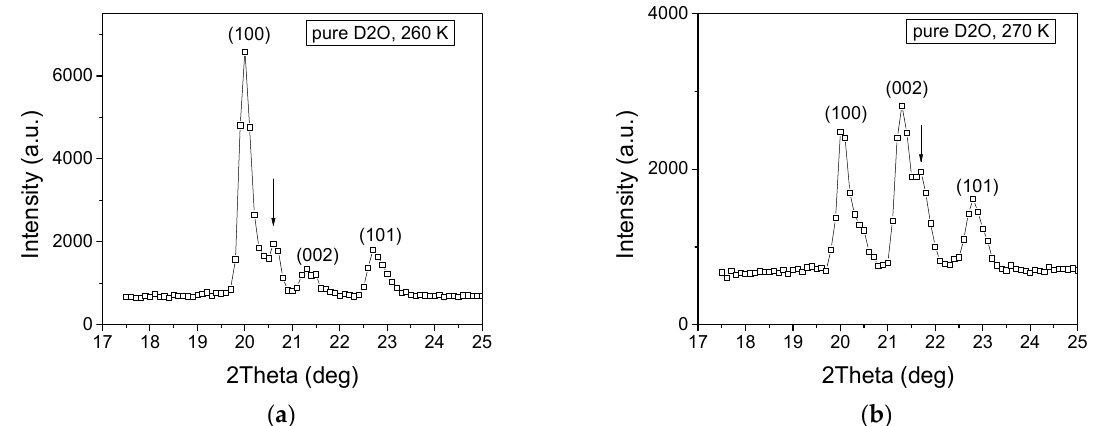
Figure 5. The split of D 2 O ice diffraction lines (100) and (002) (marked by an arrow) observed for a pure D 2 O sample cooled down to 260 K ( a ) and 270 K ( b ); the difference in intensity of the diffraction lines caused by crystallographic texture changes is also apparent.